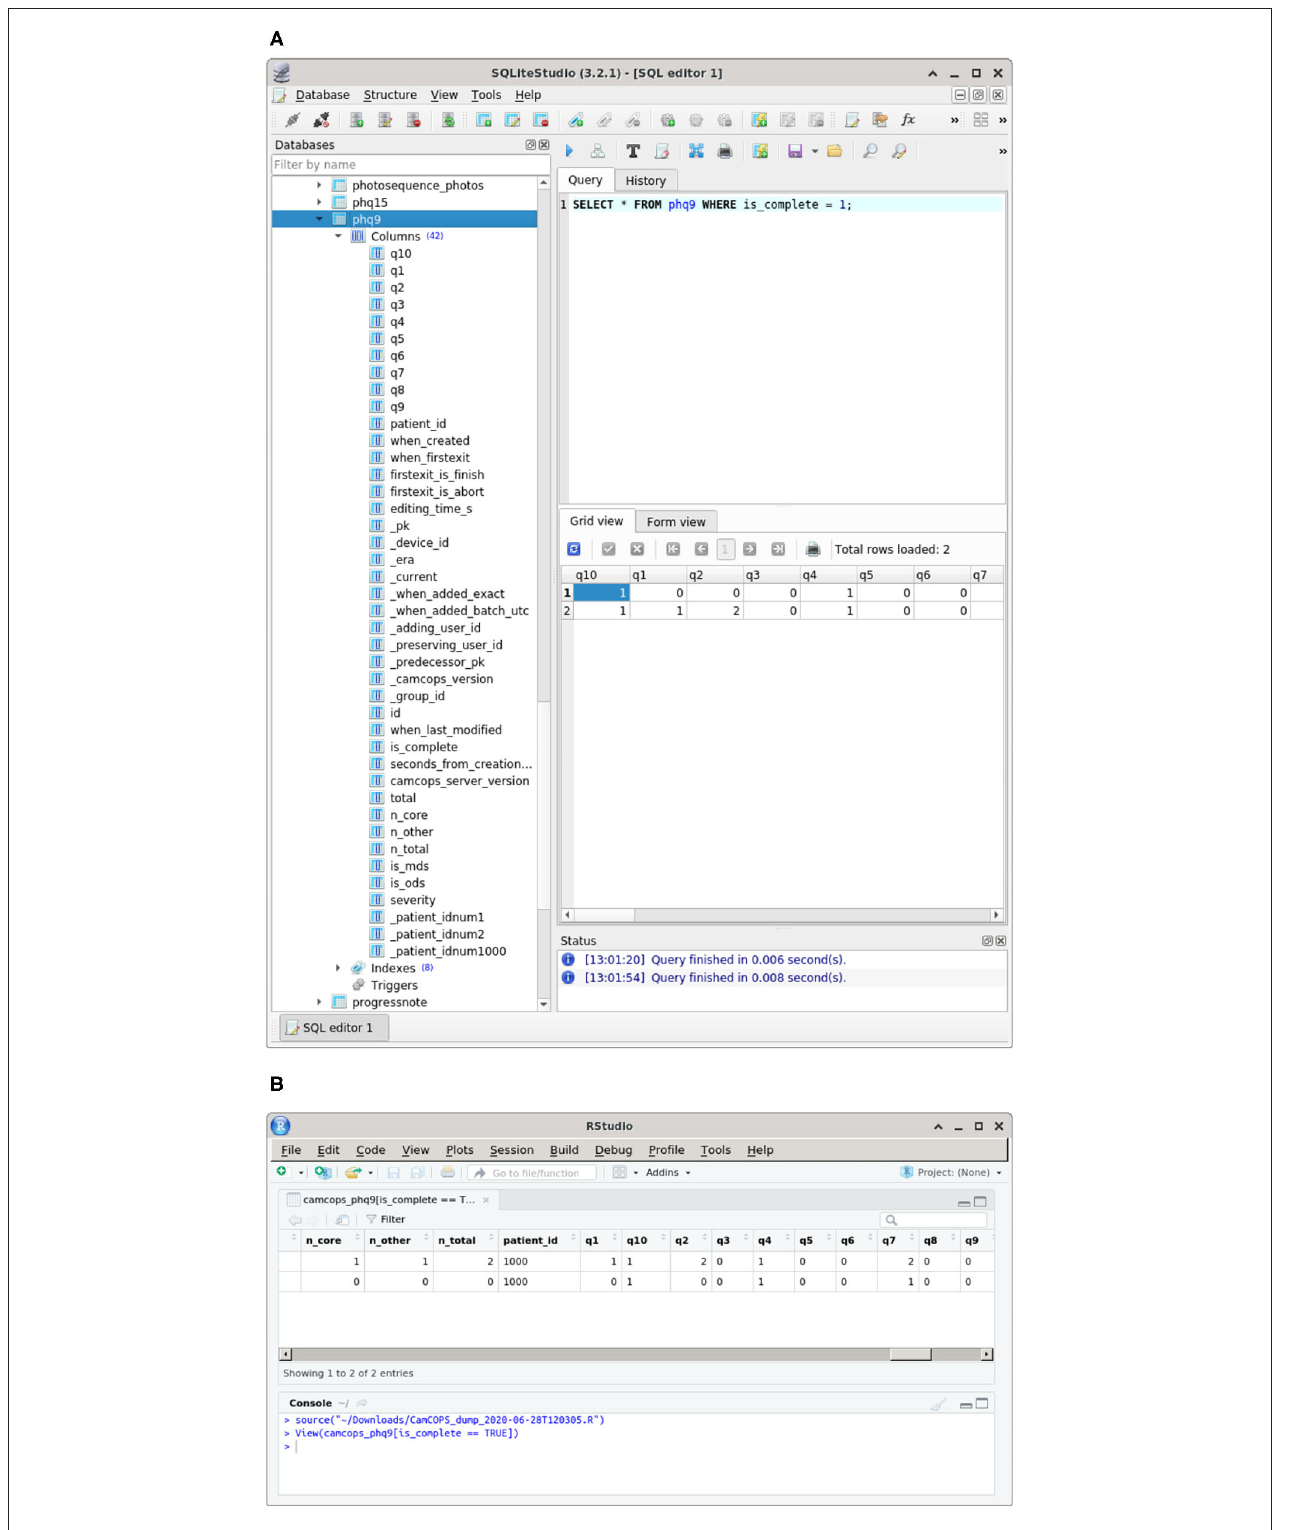
FIGURE 5 | Some research-oriented methods of data access. (A) Structured data in a relational database downloaded from CamCOPS. An SQLite database (25) is shown in SQLiteStudio (28). (B) Data downloaded and imported directly into R (24), shown inside RStudio (29). All data are fictional.